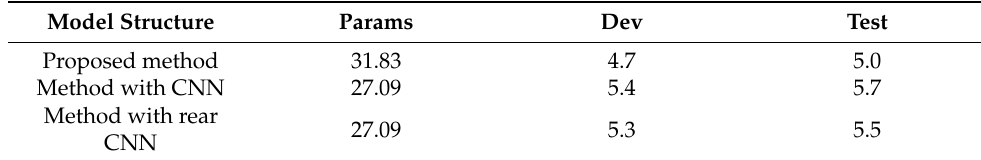
Table 4. Comparison of different model structure.